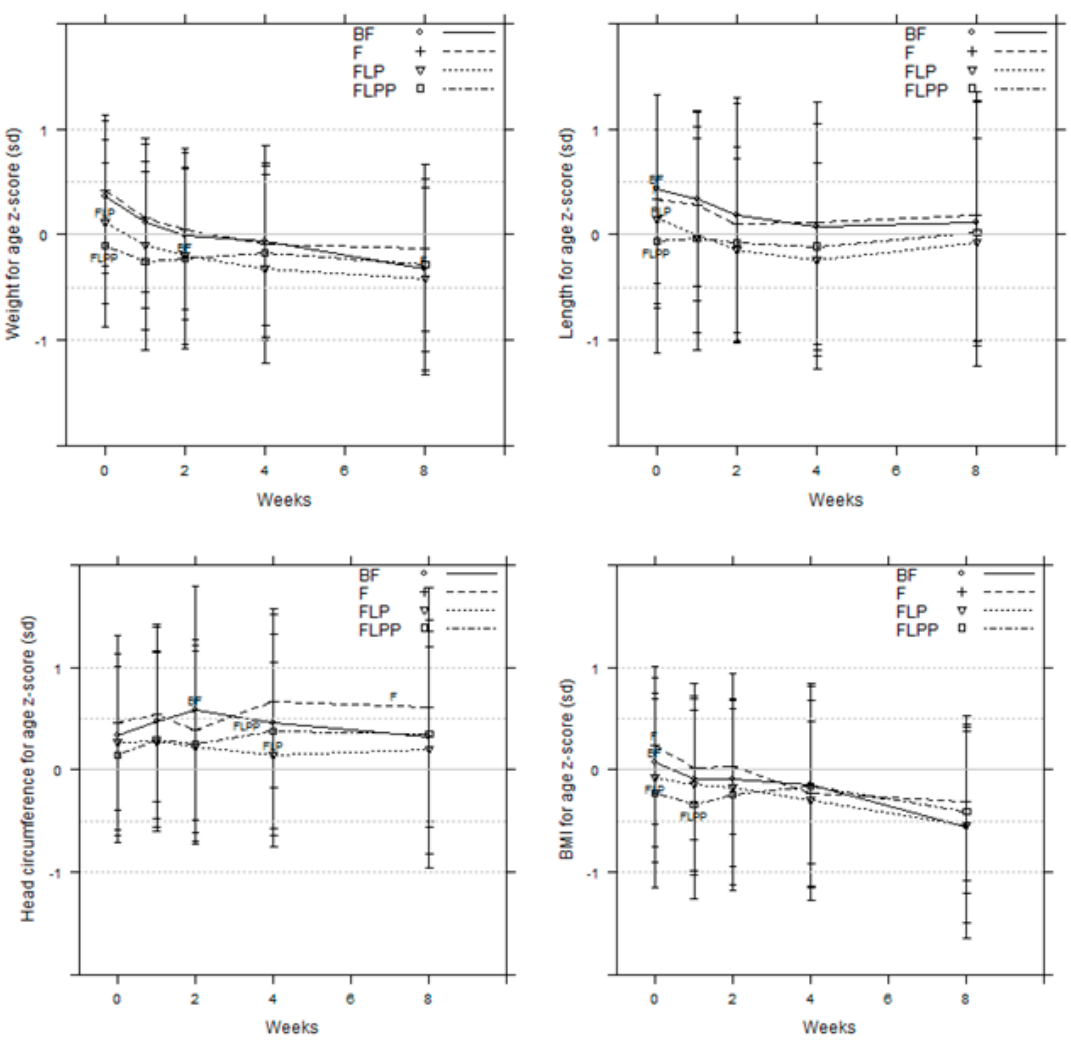
Figure 5. Anthropometric data. z-scores for body weight, length, head circumference, and BMI (PP data set).